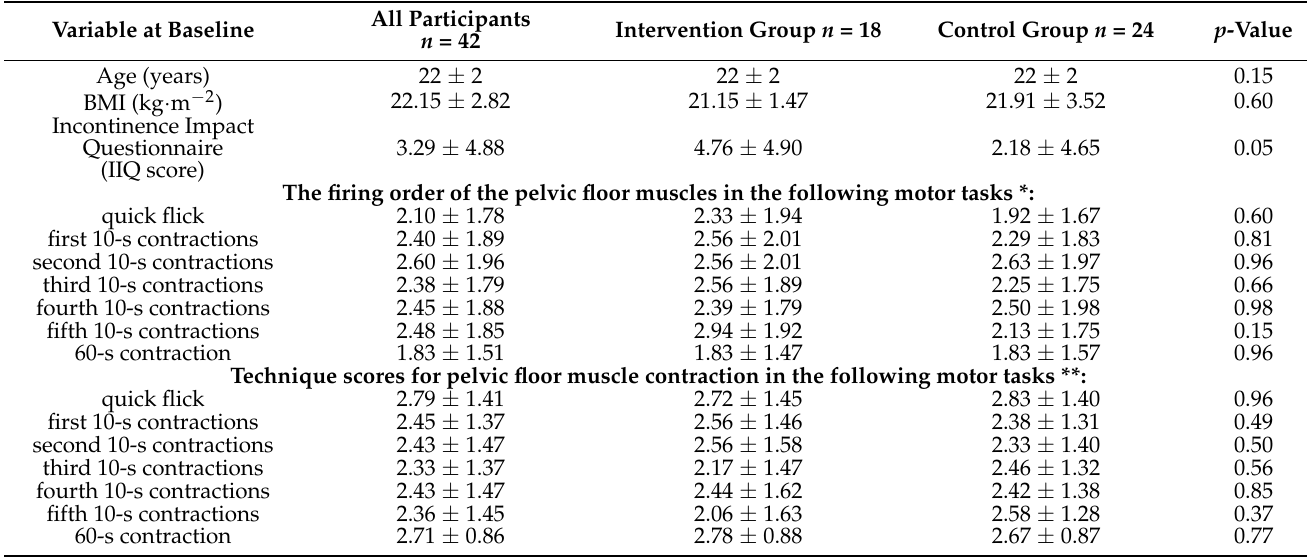
Table 1. Characteristics of the study participants.